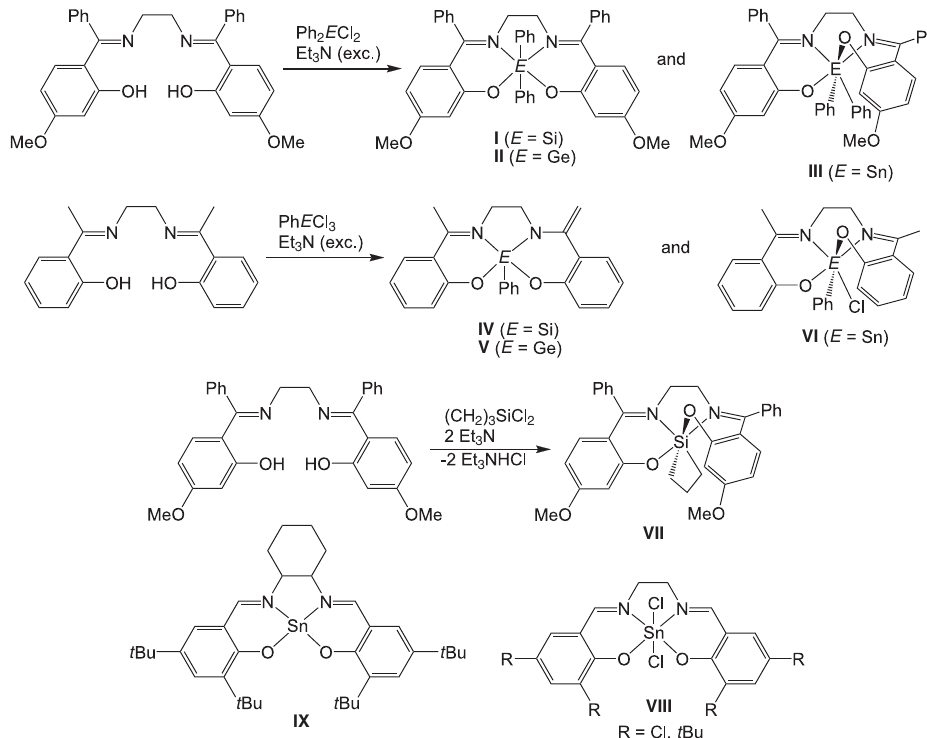
Scheme 1 Selected Si, Ge, and Sn complexes with salen-type